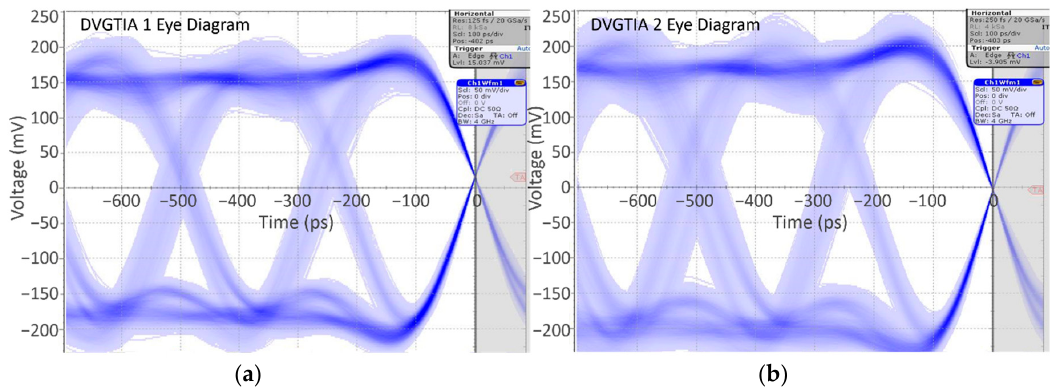
Figure 12. ( a ) Measured eye diagrams with 5 Gb/s PRBS input signal of DVGTIA design 1 and ( b ) DVGTIA design 2.